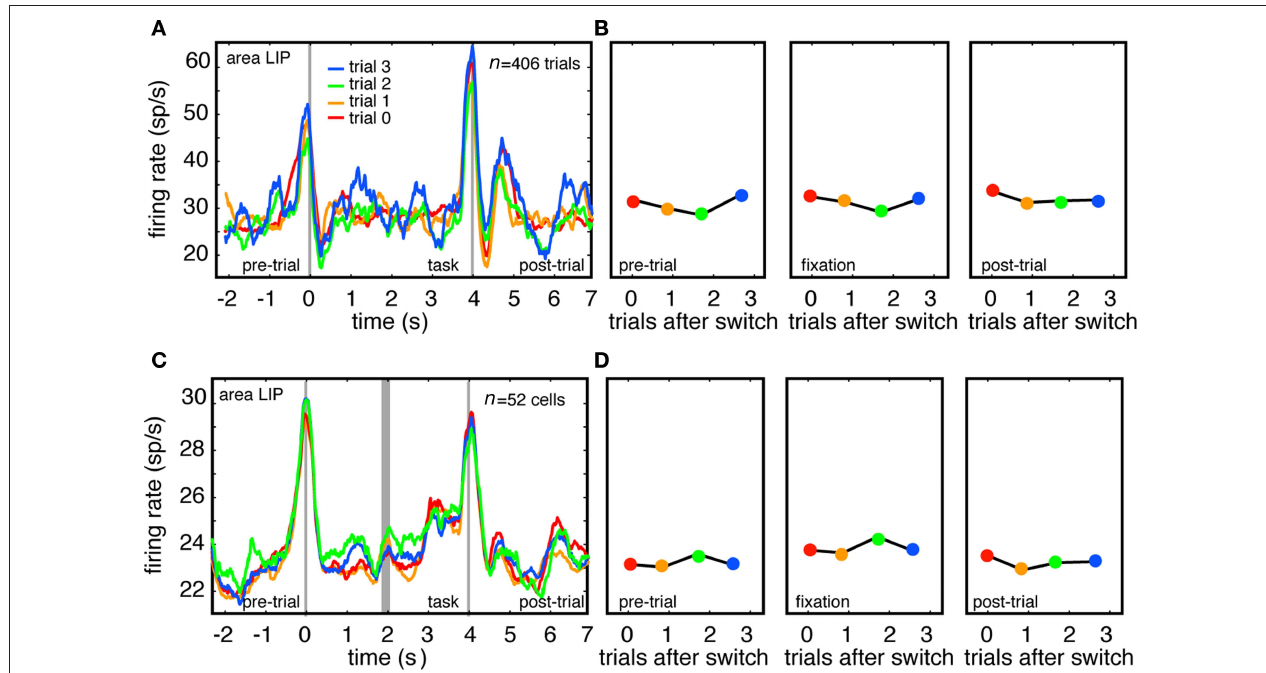
of LIP neurons immediately after switch, and on first, second, and third trial following switch. Because tasks were different lengths in monkeys N (4 s) and D (3 s), responses are separately aligned to trial onset (time = 0) and trial offset (time = 4), separated by thick gray line. (D) Plot of average firing rate during each of three task epochs (pre-trial, fixation, post-trial across